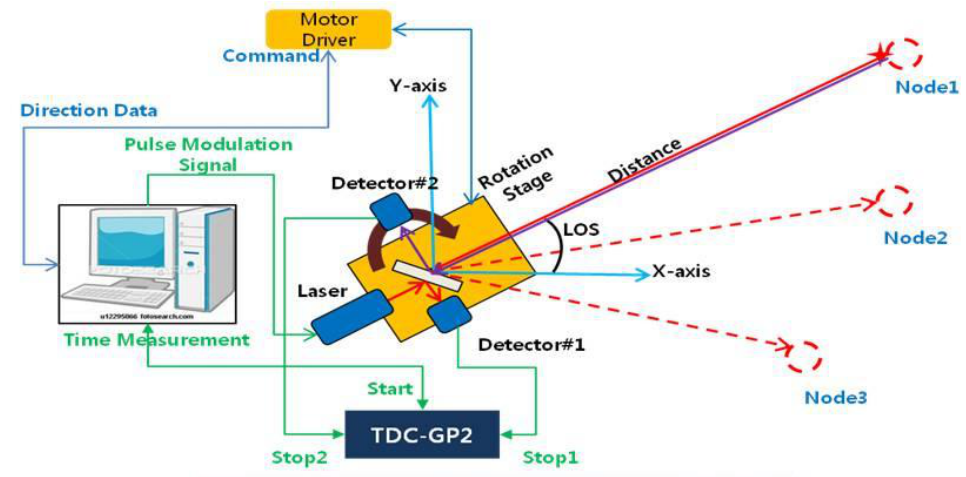
Figure 2. Design of the base station system.